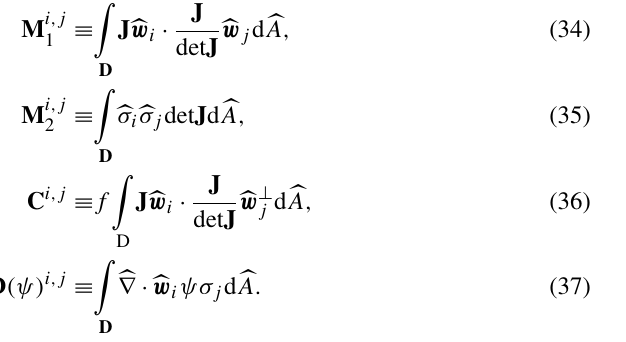
Table 1. The normalised (cid:96) 2 and (cid:96) ∞ geopotential error norms for the Williamson 2 test (top) and the normalised (cid:96) 2 and absolute (cid:96) ∞ geopotential error norms for the Williamson 5 test (bottom) at dif- ferent resolutions after